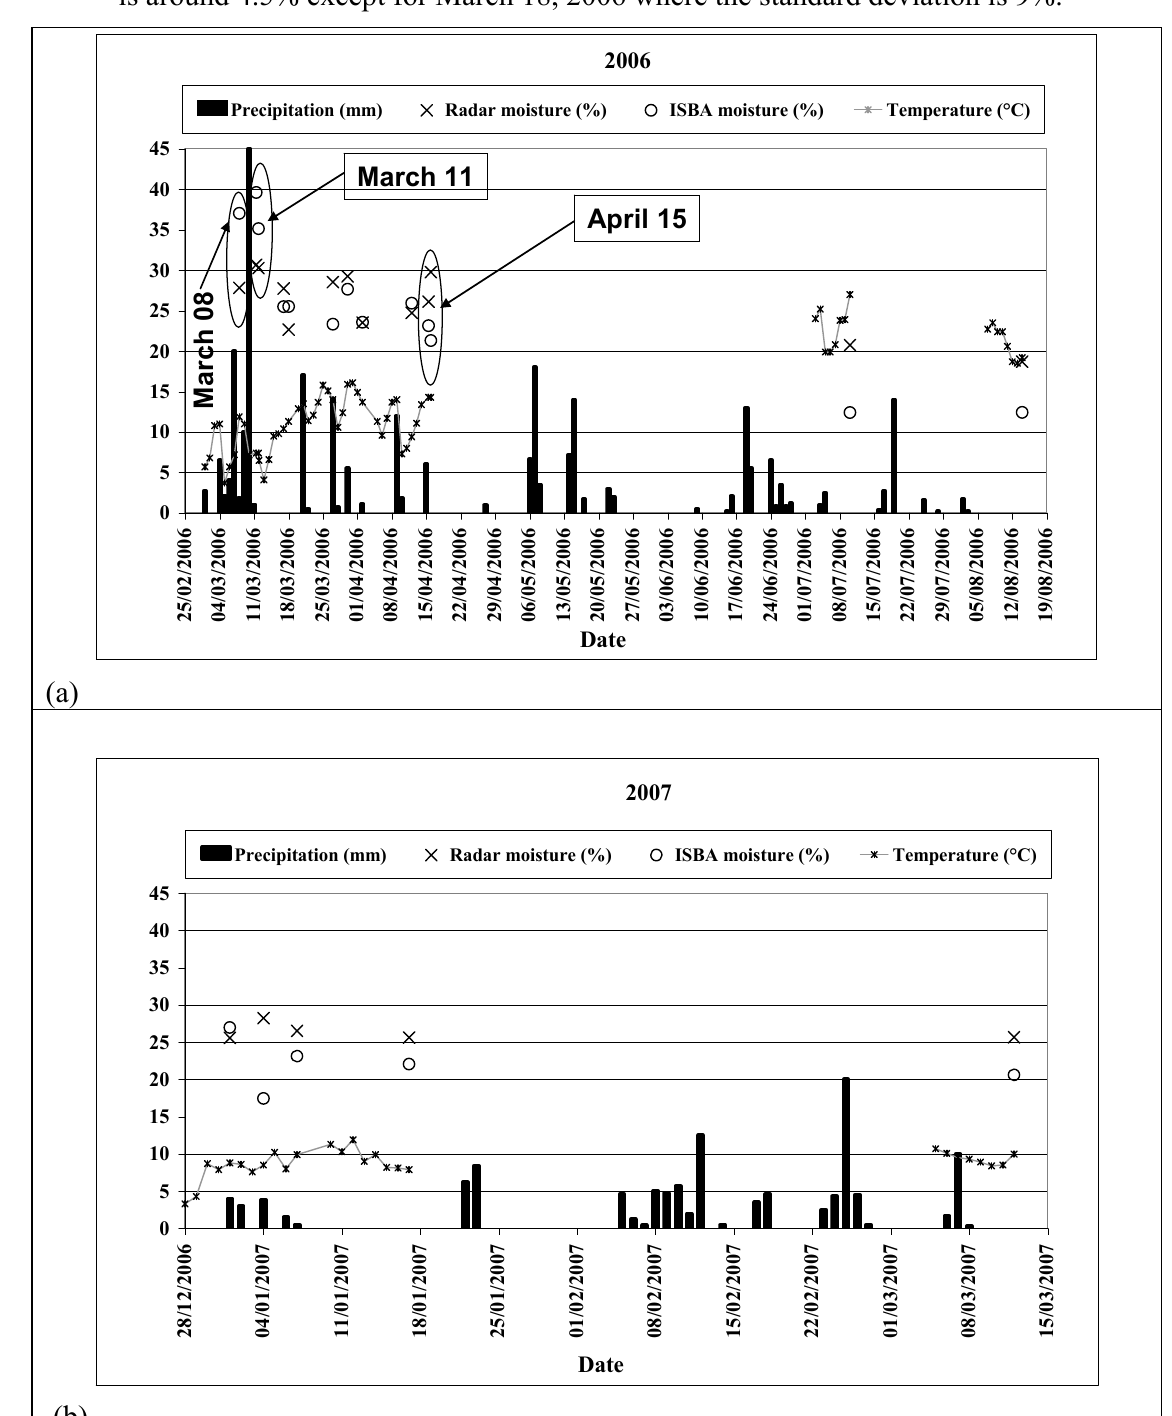
Figure 7. Soil moistures obtained from radar images, ISBA model, and in situ measurements (Gravimetry) according to daily precipitation. Each soil moisture value corresponds to the average soil moisture on the catchment basin (one soil moisture value for the whole of the basin). The standard deviation of basin average soil moisture values is around 4.5% except for March 18, 2006 where the standard deviation is